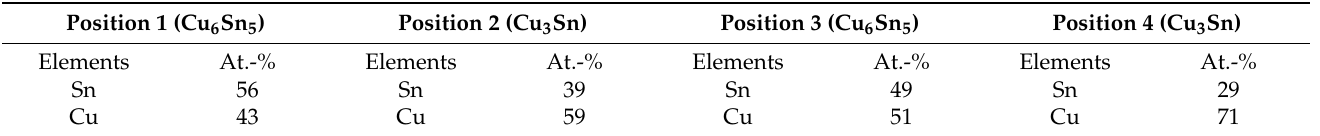
Table 3. EDS analysis of chemical composition of the intermetallic compounds by a FIB-investigation (Position 1 and Position 2) and TEM-investigation (Position 3 and Position